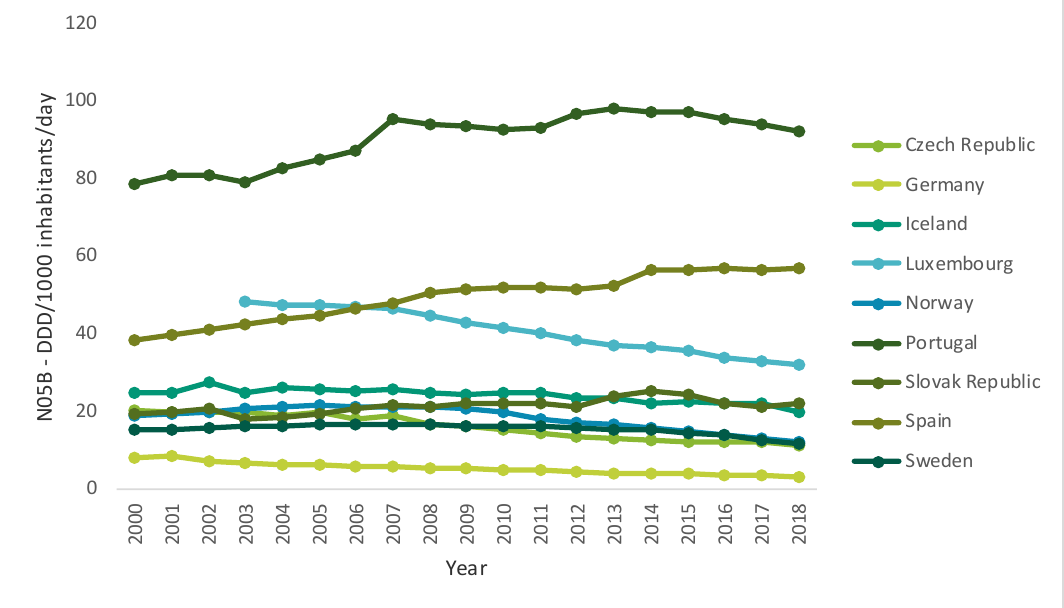
Figure 1. Use of anxiolytics (N05B) in some Organization for Economic Cooperation and Development (OECD) countries from 2000 to 2017 (DDD/1000 inhabitants/day) (data from [24]).